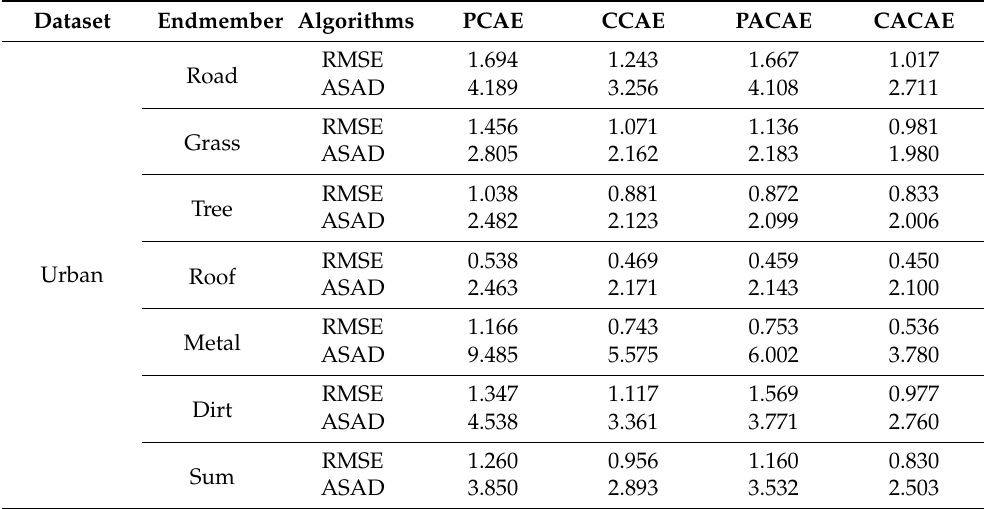
Table 5. RMSE and ASAD results for all endmembers of the Urban dataset ( × 10 − 1 ).